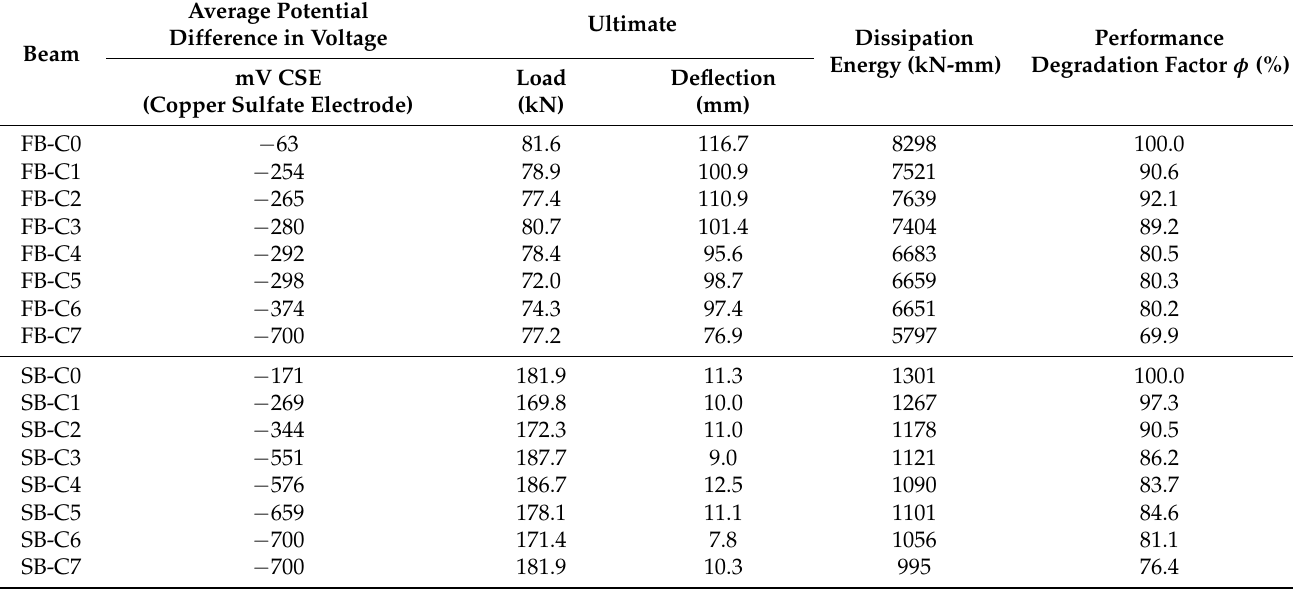
Table 2. Test results for each specimen.